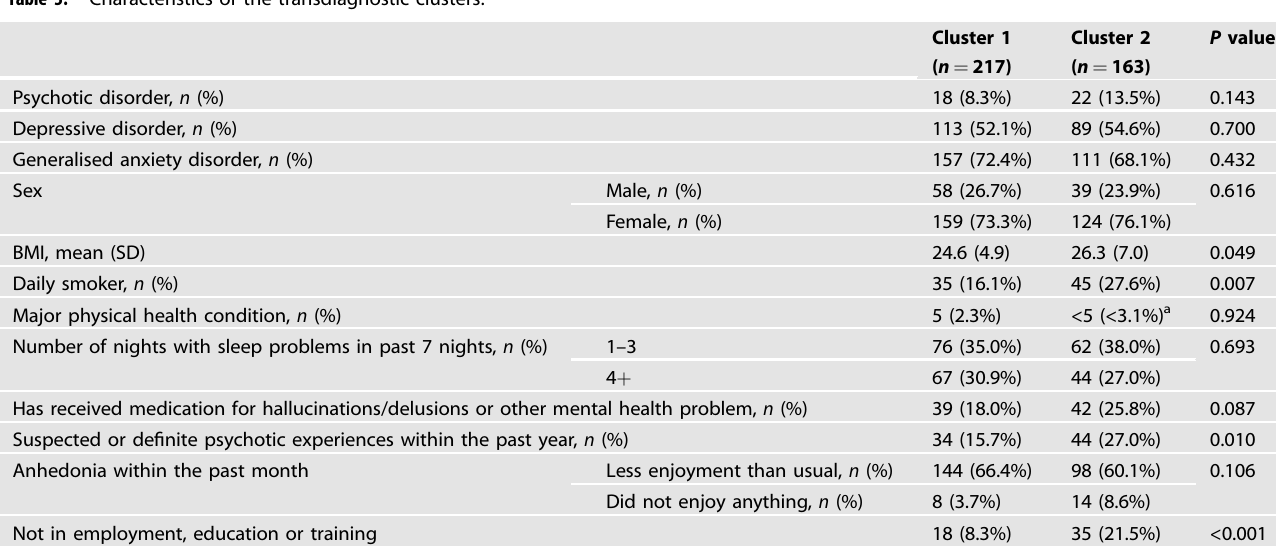
Table 3. Characteristics of the transdiagnostic